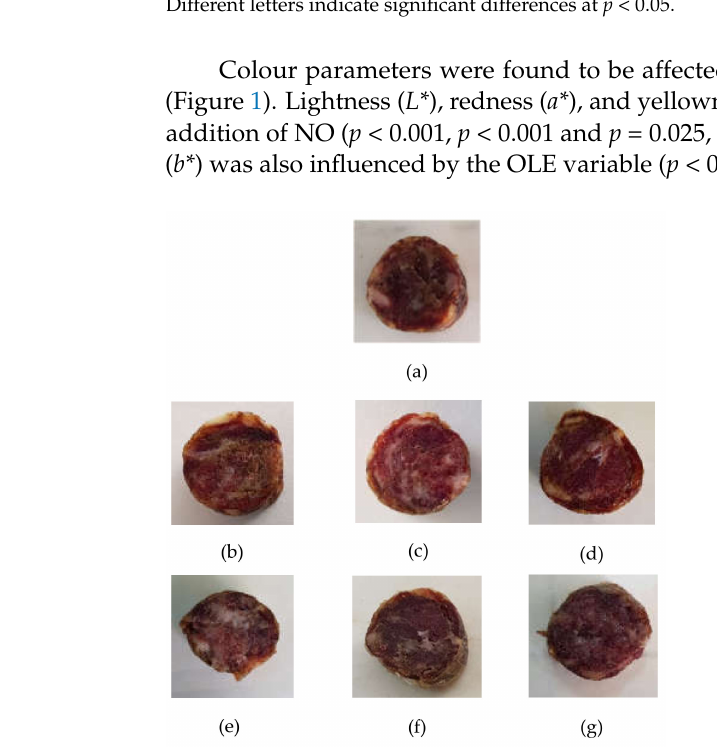
Figure 1. Colour variation of the ripened sausages under investigation: ( a ) CTRL (0 mg/kg OLE; 300 mg/kg NO); ( b ) Tr1 (200 mg/kg OLE; 150 mg/kg NO); ( c ) Tr2 (400 mg/kg OLE; 150 mg/kg NO); ( d ) Tr3 (800 mg/kg OLE; 150 mg/kg NO); ( e ) Tr4 (200 mg/kg OLE; 0 mg/kg NO); ( f ) Tr5 (400 mg/kg OLE; 0 mg/kg NO); ( g ) Tr6 (800 mg/kg OLE; 0 mg/kg